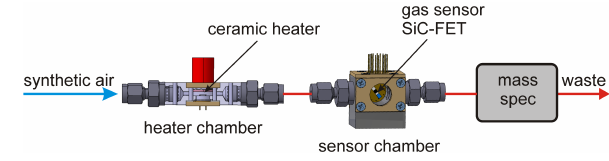
Figure 4. Schematic of the setup used with a mass spectrometer in the